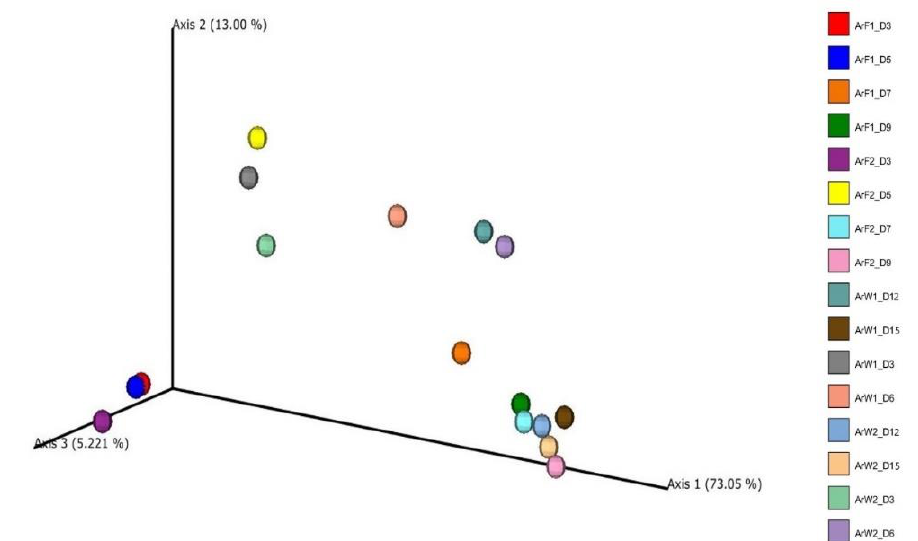
Figure 3. Principal coordinate plot based on weighted UniFrac distance. Different color corresponds to different sample/day. Whole (ArW) and filleted (ArF) chill-stored meagre caught in January (1) and July (2).